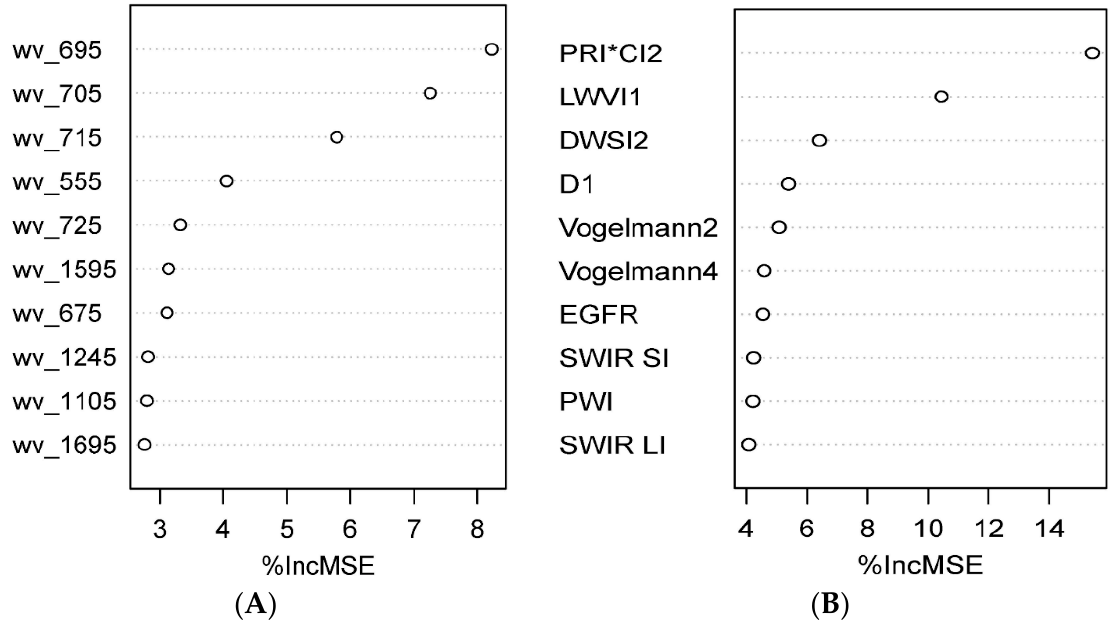
Figure 4. Random forest model selection of the most important ( A ) ten out of 164 wavebands and ( B ) ten out of 115 vegetation indices for predicting CC biomass using hyperspectral data. (wv = wavebands, %incMSE = % increase in mean square error (MSE)).